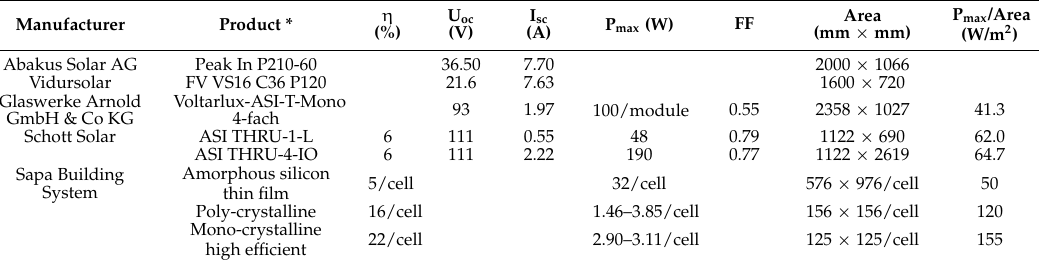
Table 4. Literature data for some solar cell glazing products